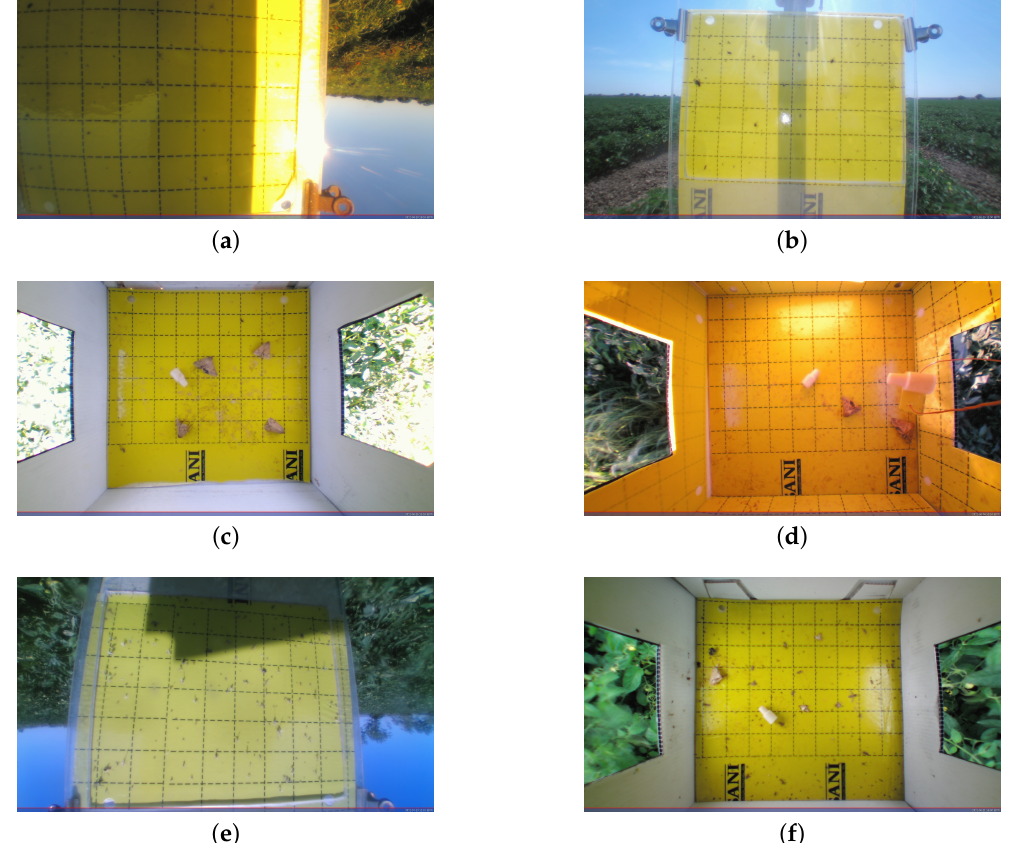
Figure 1. Examples of the data set. ( a ) Insect Trap 001. ( b ) Insect Trap 002. ( c ) Insect Trap 003. ( d ) Insect Trap 004. ( e ) Insect Trap 005. ( f ) Insect Trap